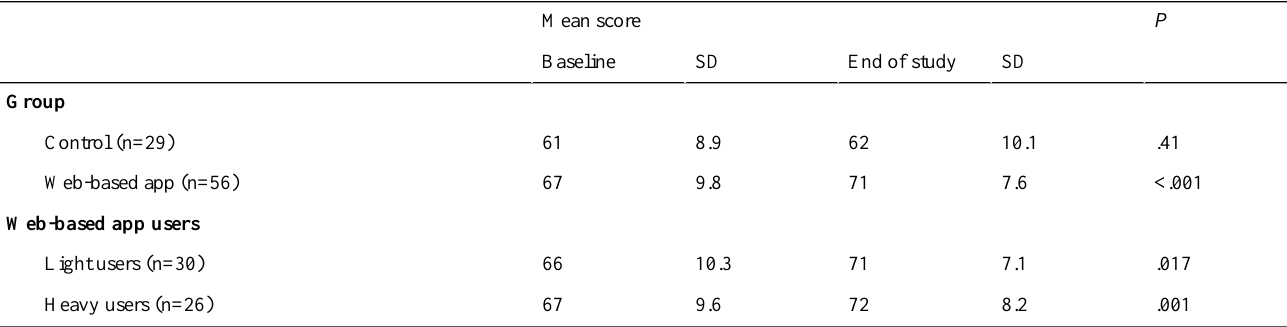
Table 4. Diet quality score at baseline and at the end of the